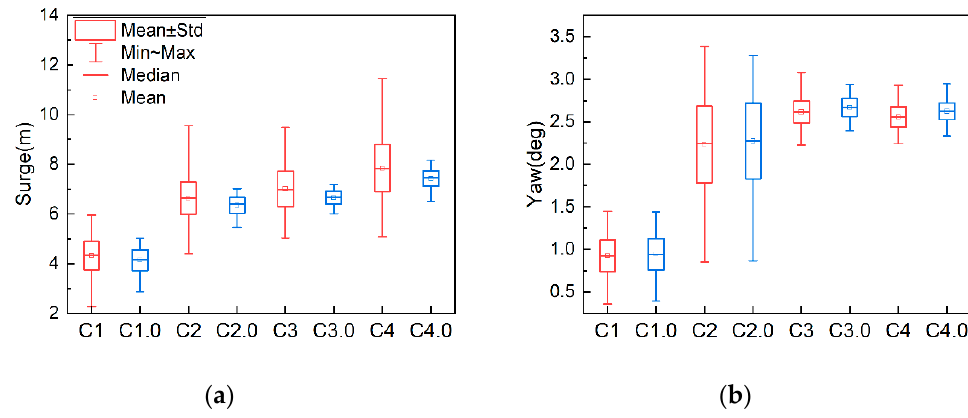
Figure 14. Buoy motion under different wind–wave sea scenarios. ( a ) Surge; ( b ) Yaw.